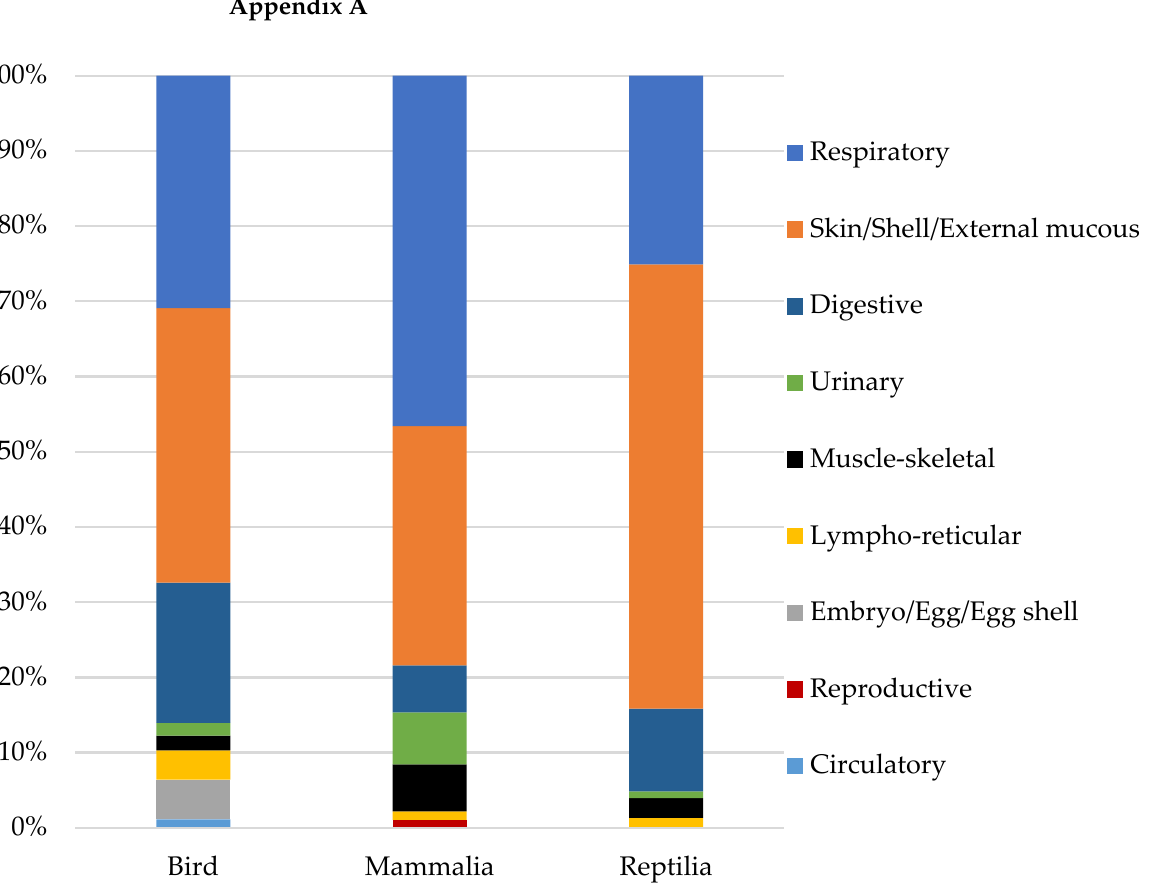
Figure A1. Distribution of samples according to the animal class and the sample origin, following the grouped categories.